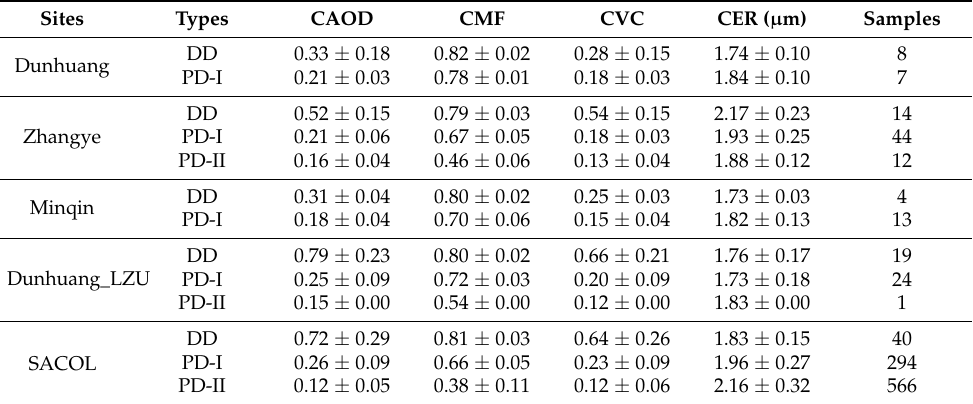
Table 2. The average and SD of four key parameters at five sites in Northwest China for the DD, PD-I, and PD-II